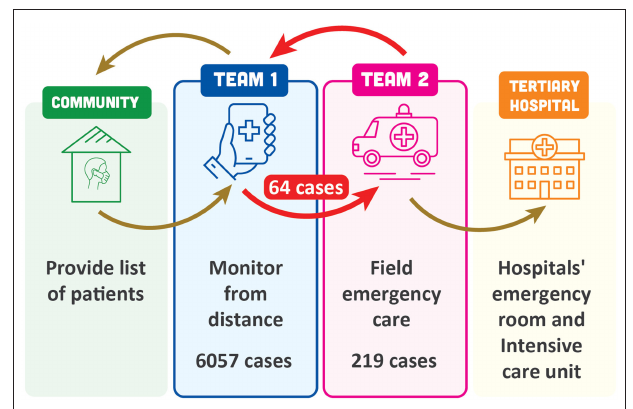
FIGURE 1 | Community-based care model for patients with COVID-19 in District 10, Ho Chi Minh City,